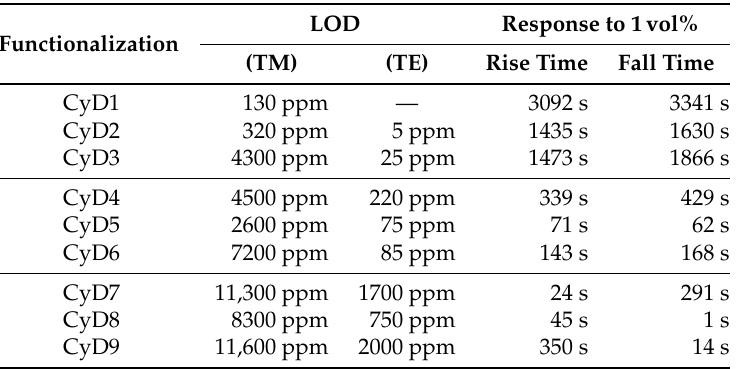
Table 1. Estimated CFC-11 limit-of-detection of the PBG-sensor sensitized with the different cyclodextrin derivatives for the TM- and TE-polarization caused Bragg reflections as well as the sensor response at a concentration of